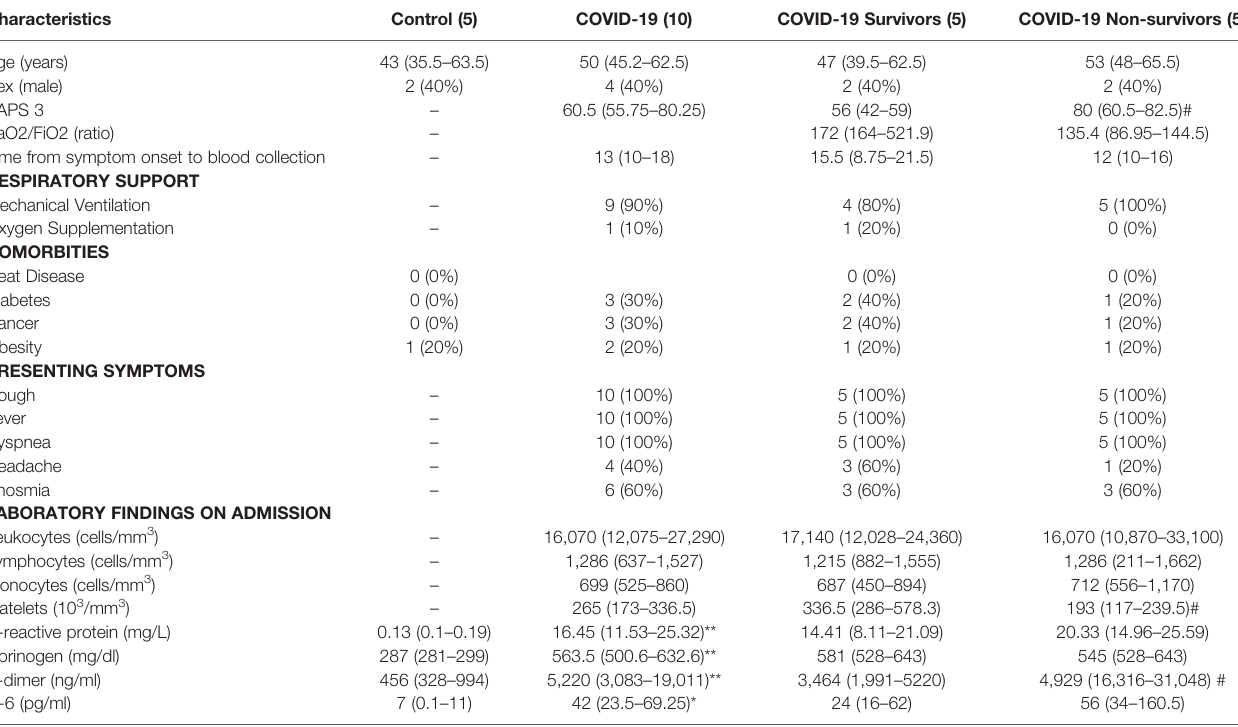
TABLE 1 | Clinical Characteristics of COVID-19 patients and control subjects in the proteome